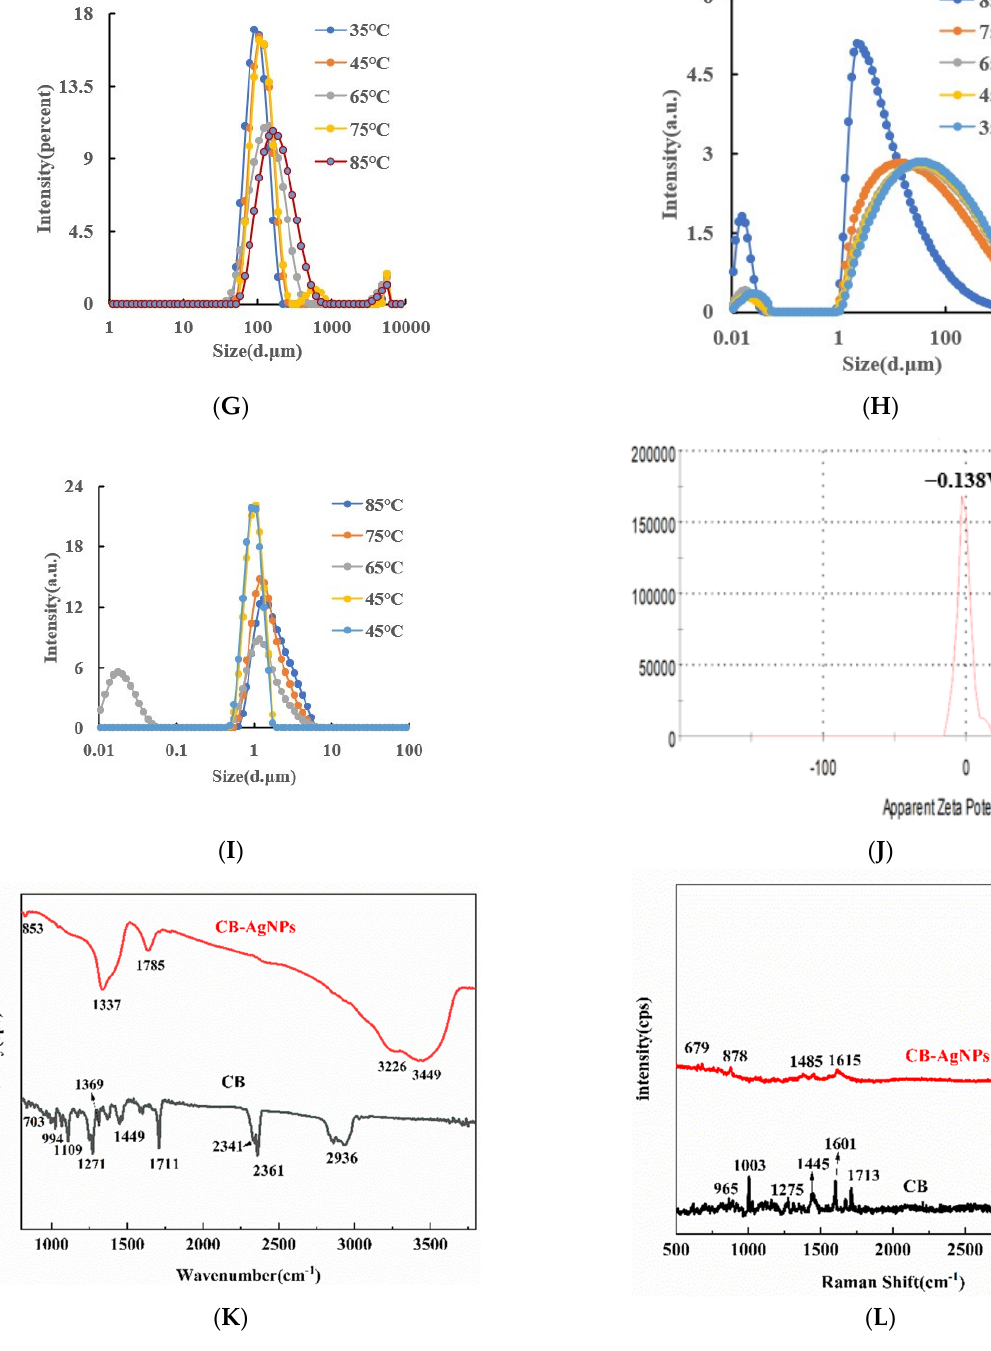
Figure 3. Molecular spectroscopy, particle size analysis and surface charge analysis of small molecule CB/CB@AgNPs/AgNPs. ( A – C ): Represents the RRS spectra of 0.01mmol/L CB/CB@AgNPs/AgNPs at different temperatures, respectively; ( D – F ): Abs spectra of 0.01mmol/L CB/CB@AgNPs/AgNPs at different temperatures, respectively; ( G – I ): Particle size distribution of 0.01mmol/L CB/CB@AgNPs/AgNPs at different temperatures, respectively; ( J ): 0.01mmol/L CB (zeta potential = − 0.138mV); ( K ): Normal Raman spectrum (CB/CB@AgNPs); ( L ): FITR spectrum (CB/CB@AgNPs).